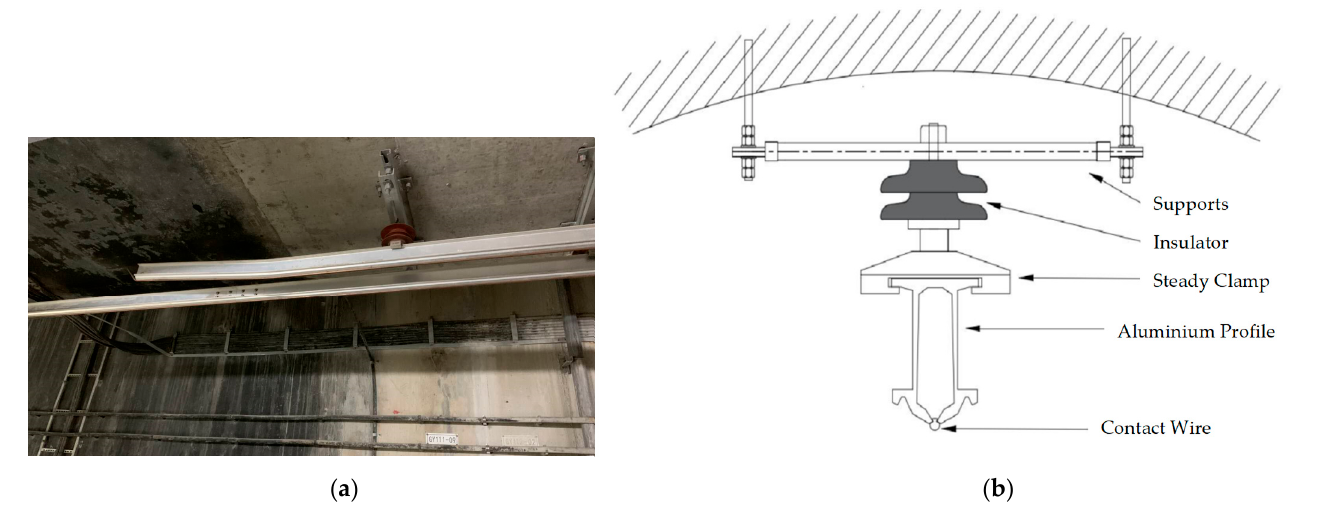
Figure 2. A rigid catenary system. ( a ) Discontinuous layout along the rigid catenary. ( b ) The cross-section and key components of a rigid catenary system.